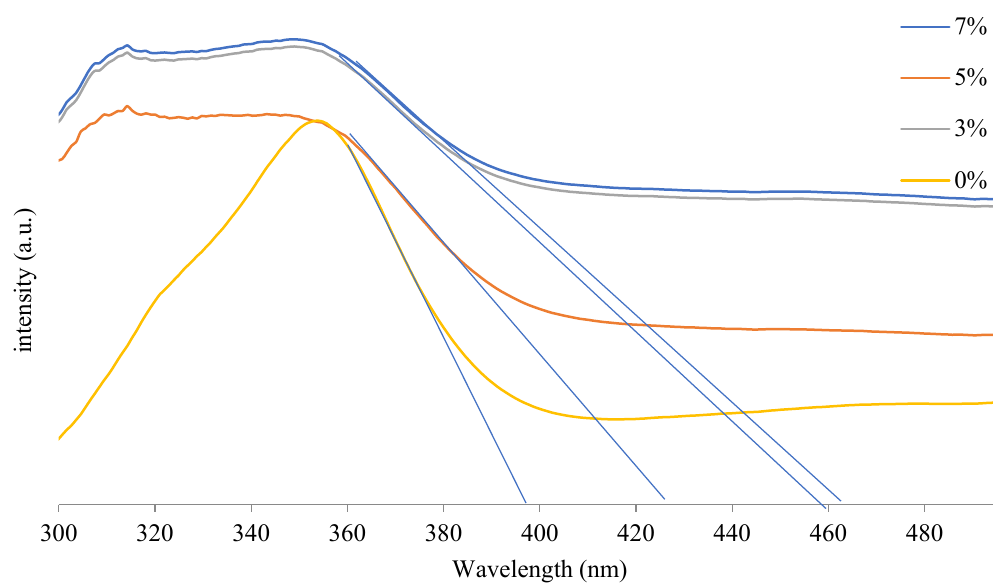
Fig. 5. UV–vis absorption spectra of pure and Sn-doped TiO